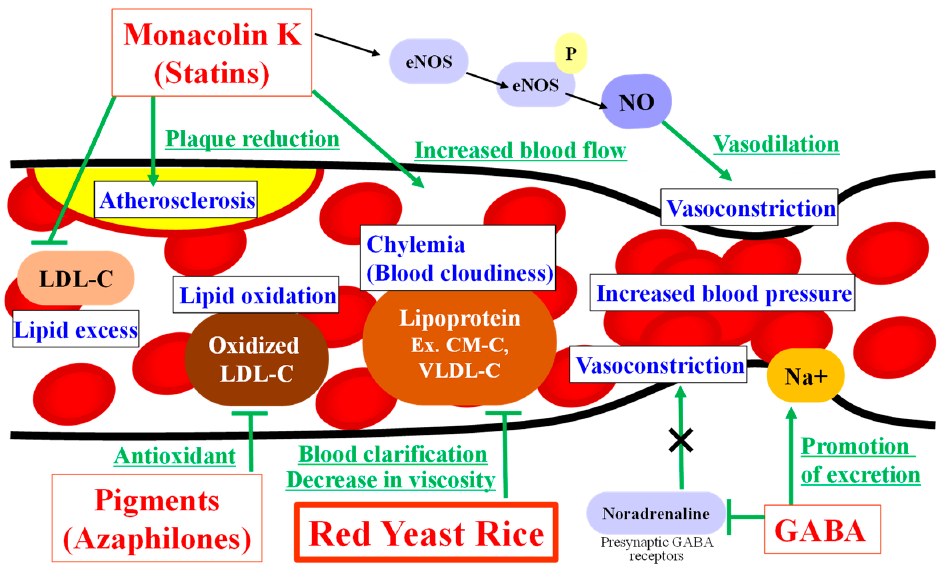
Figure 18. Expected effect on the circulatory system of red yeast rice and its components.